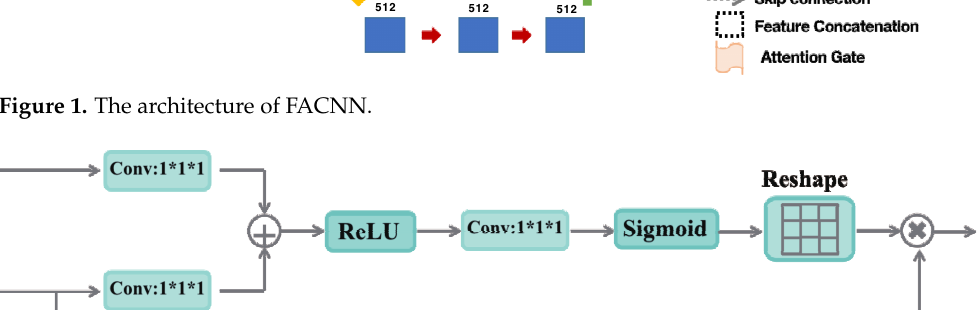
Figure 2. The architecture of the